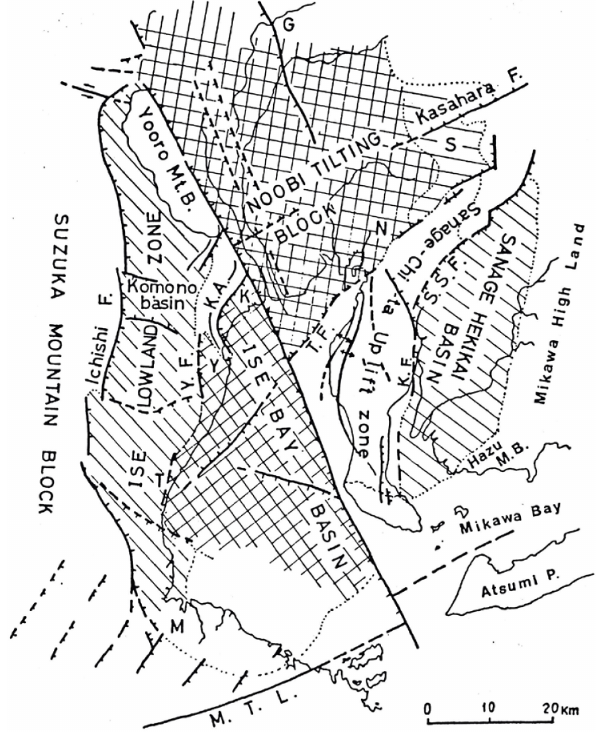
Figure 6. Quaternary block faulting in the Nohbi Plain and Ise Bay region (Kuwahara,